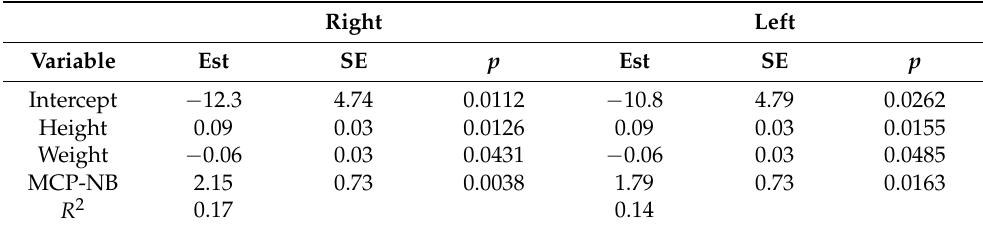
Table 2. Regression models based on personal